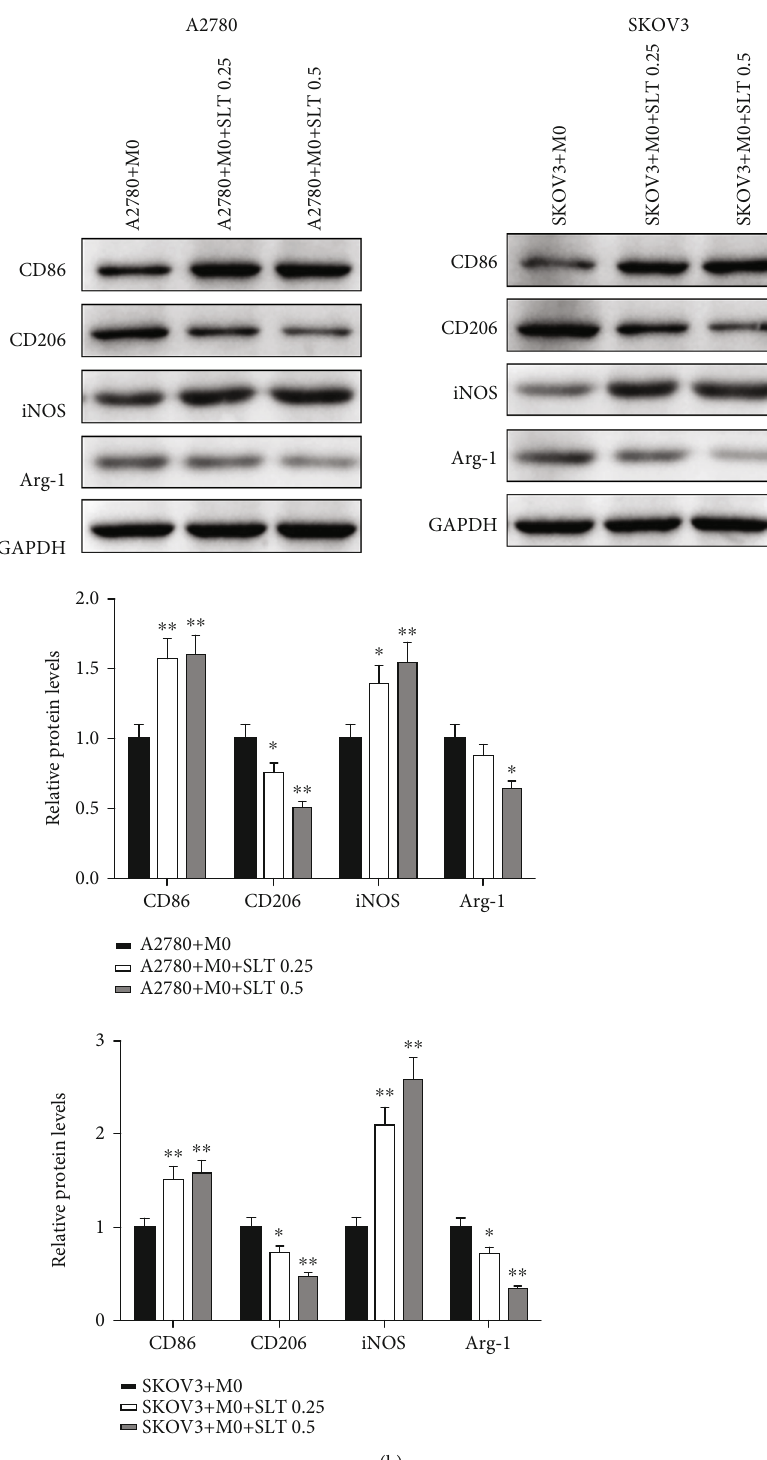
Figure 7: SLT regulates the polarization of M0 macrophages in coculture with ovarian cancer cells. (a) Flow cytometry assay was performed to analyze the M1 and M2 polarization in M0 macrophages, and the percentages of CD86+ and CD206+ cells were detected. (b) The protein expressions of CD86, CD206, iNOS, and Arg-1 were detected using western blotting. The values were displayed as the mean ± SD . Representative results from three independent experiments were shown ( ∗ P < 0 : 05 , ∗∗ P < 0 : 01 , and ∗∗∗ P < 0 : 001 compared with the A2780/SKOV3+M0